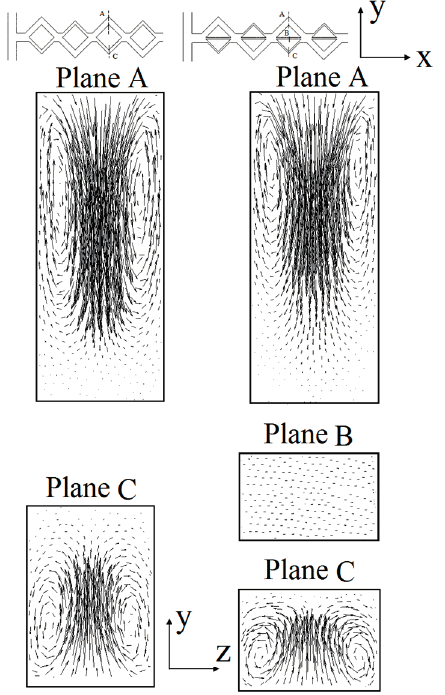
Figure 7. Velocity vector plots on y - z planes at Re = 40 in unbalanced two-split and three-split rhombic